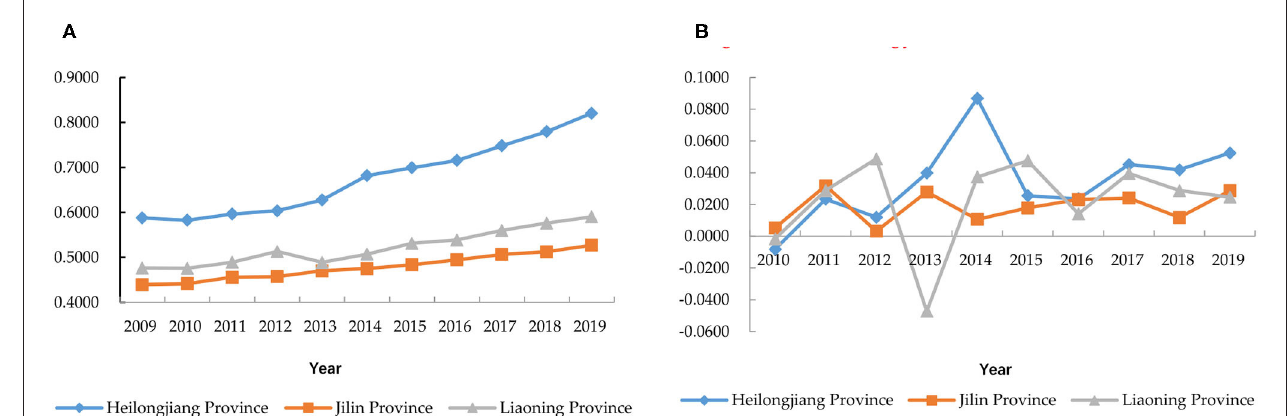
FIGURE 2 | The correlation degree of each dimension of agricultural green development in the three northeastern provinces of China (2009–2019). (A) Agricultural development; (B) ecological resource protection; (C) environment-friendly; (D) industrial extension and integration.